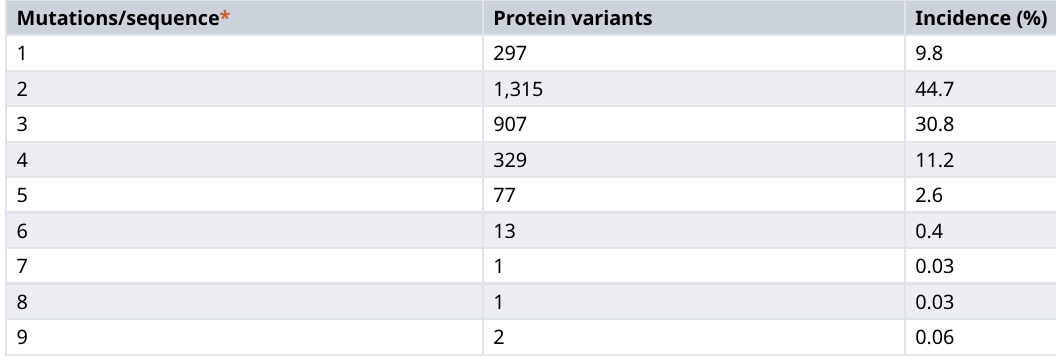
Table 1. The combinatorial landscape of mutations arising in the S-protein during 2020. Mutations/sequence* Protein